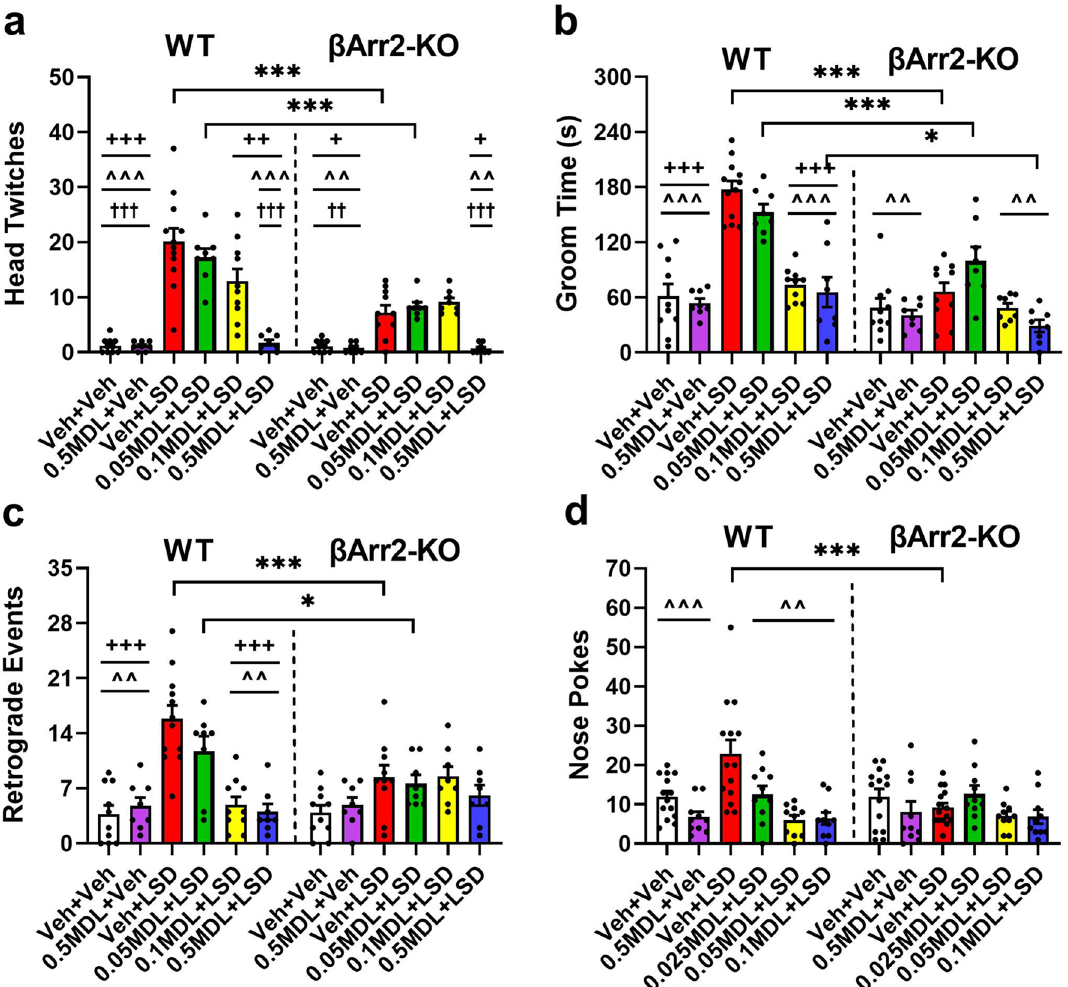
Figure 4. Effects of LSD and MDL100907 on behavioral responses in β-arrestin 2 mice. A description of the experimental design is presented in the Fig. 3 legend. ( a ) LSD-stimulated head twitch responses in WT and βArr2-KO mice. A two-way ANOVA reported significant genotype [F(1,96) = 31.271, p < 0.001] and treatment effects [F(5,96) = 41.567, p < 0.001]; the genotype by treatment interaction was also significant [F(5,96) = 7.734, p < 0.001]. ( b ) LSD-stimulated grooming in βArr2 animals. A two-way ANOVA demonstrated significant genotype [F(1,96) = 51.972, p < 0.001] and treatment effects [F(5,96) = 27.987, p < 0.001]; the genotype by treatment interaction was also significant [F(5,96) = 7.953, p < 0.001]. ( c ) LSD-stimulated retrograde walking in βArr2 subjects. A two-way ANOVA found significant treatment effects [F(5,96) = 13.028, p < 0.001]; the genotype by treatment interaction was also significant [F(5,96) = 5.199, p < 0.001]. ( d ) LSD-stimulated nose poking in WT and βArr2-KO mice. A two-way ANOVA observed significant treatment effects [F(5,125) = 7.512, p < 0.001]; the genotype by treatment interaction was also significant [F(5,125) = 4.769, p = 0.001]. N = 8–12 mice/ group for head twitch, grooming, and retrograde walking; N = 10–15 mice/group for nose-poking. * p < 0.05, *** p ≤ 0.001, WT vs. KO; + p < 0.05, ++ p < 0.01, +++ p ≤ 0.001, LSD vs. indicated groups within genotype; ^^ p < 0.01, ^^^ p < 0.001, 0.05MDL + LSD vs. indicated groups within genotype; †† p < 0.01, ††† p < 0.001, 0.1MDL + LSD vs. indicated groups within LSD and MDL100907 effects on prepulse inhibition. LSD disrupts PPI in both rats and humans and the response can be restored with 5-HT2AR antagonists 37,44 . βArr1 mice were pre-treated with the vehicle or with 0.1 or 0.5 mg/kg MDL. Subsequently, they were administered the vehicle or 0.3 mg/kg LSD and tested in PPI. No significant genotype or treatment effects were observed for null activity or in response to the 120 dB startle stimulus (Supplementary Figure S3a-b). In contrast, genotype effects were found in PPI where responses in the WT groups that received 0.1 or 0.5 mg/kg MDL plus LSD were higher than those in βArr1-KO animals ( p values ≤ 0.018) (Fig. 5a). As anticipated, LSD disrupted PPI in both βArr1 genotypes relative to their vehicle and 0.5 mg/kg MDL controls ( p values ≤ 0.002). Both 0.1 and 0.5 mg/kg MDL normalized PPI in WT mice to control levels. In βArr1-KO animals, PPI was still significantly disrupted in mice administered 0.1 mg/kg MDL with LSD relative to controls ( p values ≤ 0.001). Although PPI responses in the 0.5 mg/kg MDL plus LSD group were not